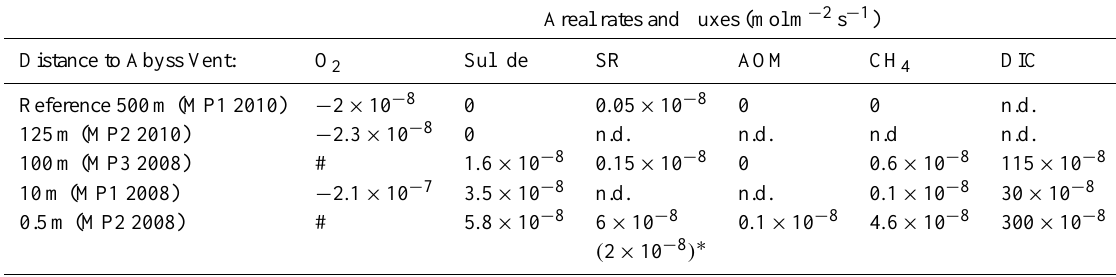
Table 2. Fluxes of oxygen and sulfide near the sediment–water interface, calculated from the microprofiles using Fick’s law of diffusion, the average integrated areal SR and AOM measured in MUC and PC taken in and near seeps, and fluxes of methane and DIC measured with the benthic chambers. The distances are between the microprofiler and the Abyss Vent. The station code is given in parentheses (see Table 1).